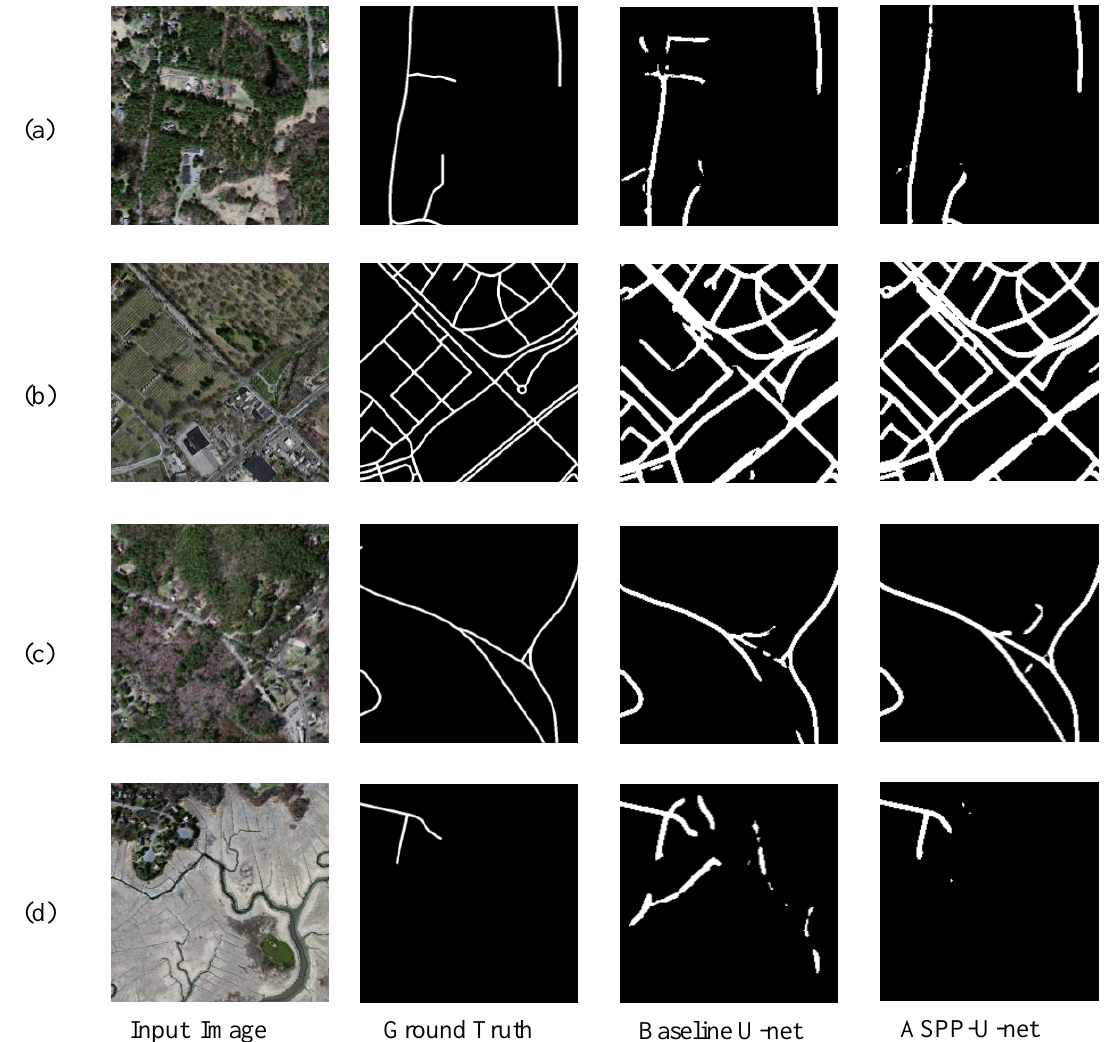
Figure 6. Visual comparisons between the baseline U-net and ASPP-integrated U-net using test samples from the Massachusetts road dataset: The results are binarized using a threshold of 0.5. For each row in ( a )–( d ), it contains an input image, a ground truth image and two result maps of a sample